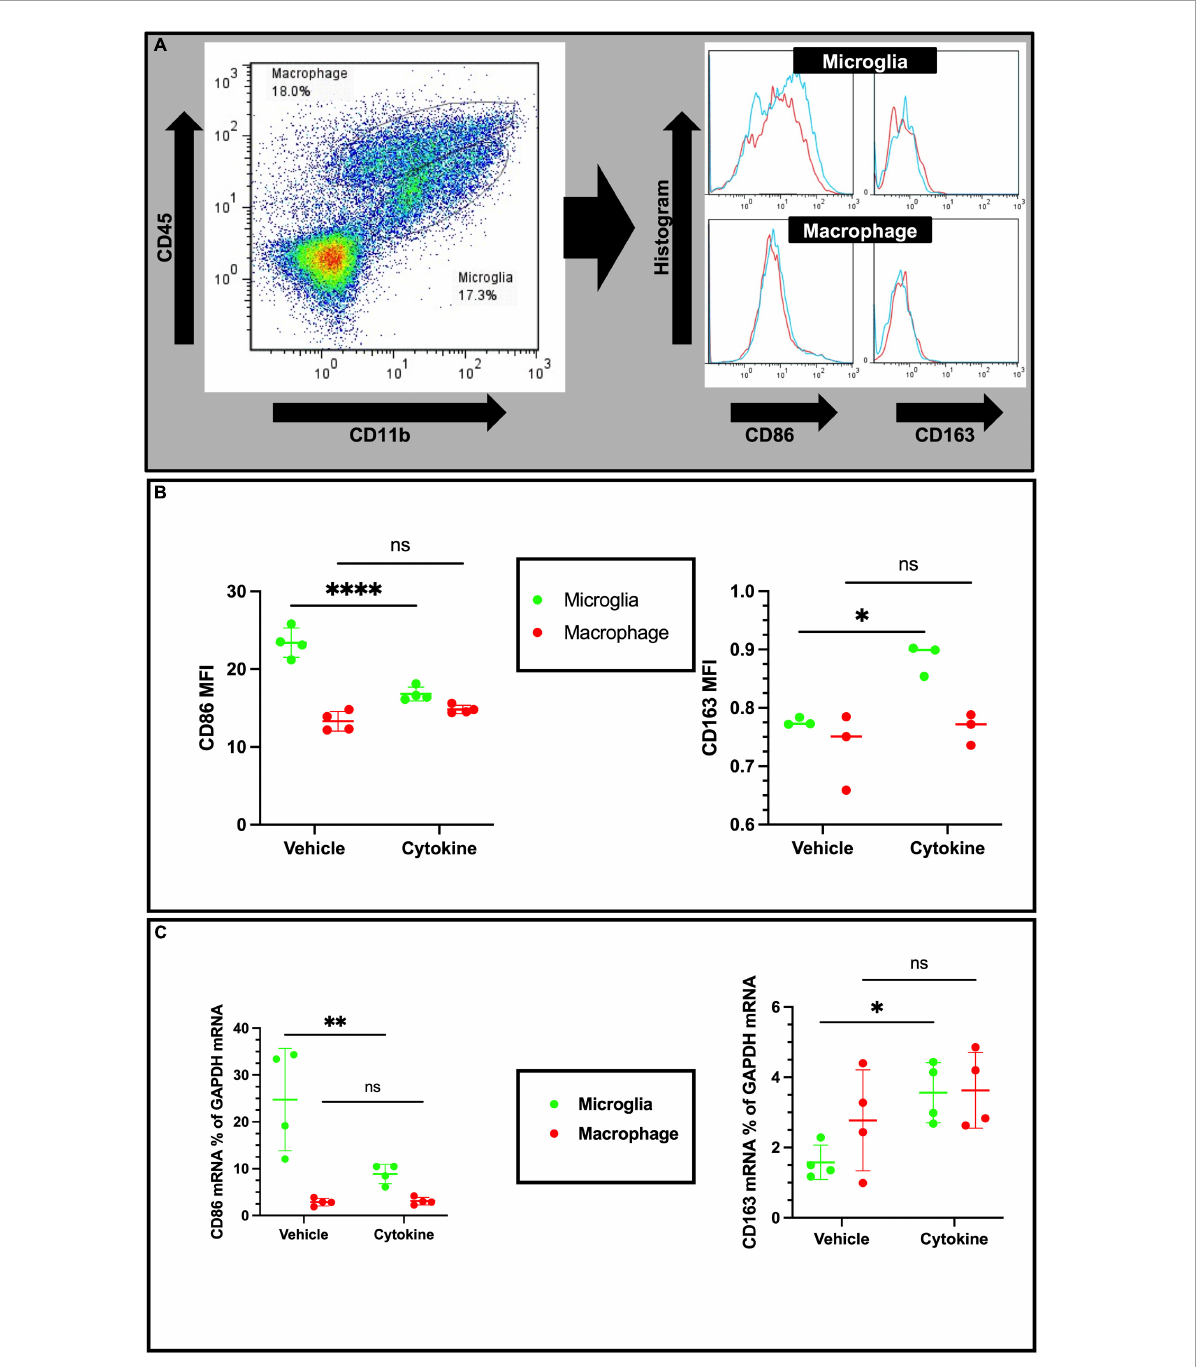
FIGURE5 Cytokines (GM-CSF and IL-3) modulate phenotypic changes in the ischemic brain at 3 dpr. (A) Gating strategy for flow cytometric analysis. The histogram shows CD86-positive and CD163-positive microglia (above) and macrophages (below). (B) Based on mean fluorescence intensity measurement, cytokine treatment decreases expression of CD86 and increases expression of CD163 on microglial cells at protein levels. (C) Expression of CD86 and CD163 encoding mRNA in sorted microglia of the ipsilateral hemisphere. Flow cytometry and qPCR data analyzed with ANOVA and are shown as means ± SD (Flow cytometry, n = 3; qPCR, n = 4). ∗ P < 0.05, ∗∗ P < 0.01, ∗∗∗∗ P < 0.0001 vs. vehicle of each group. GM-CSF, granulocyte macrophage colony-stimulating factor; IL, interleukin; dpr, days post-reperfusion; ANOVA, analysis of variance; SD, standard